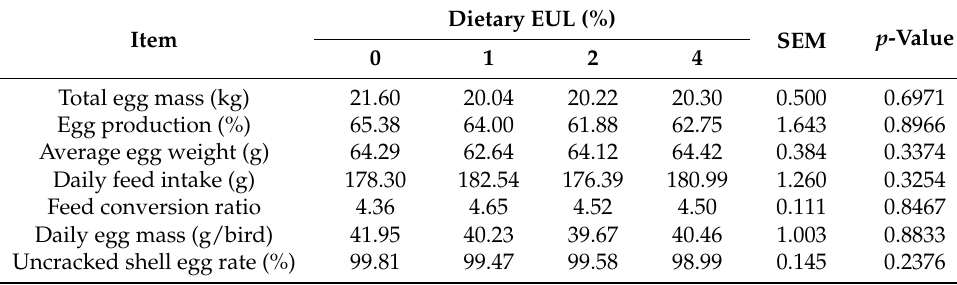
Table 2. Effects of dietary EUL on production performance for laying ducks after 6 wk of feeding 1 .